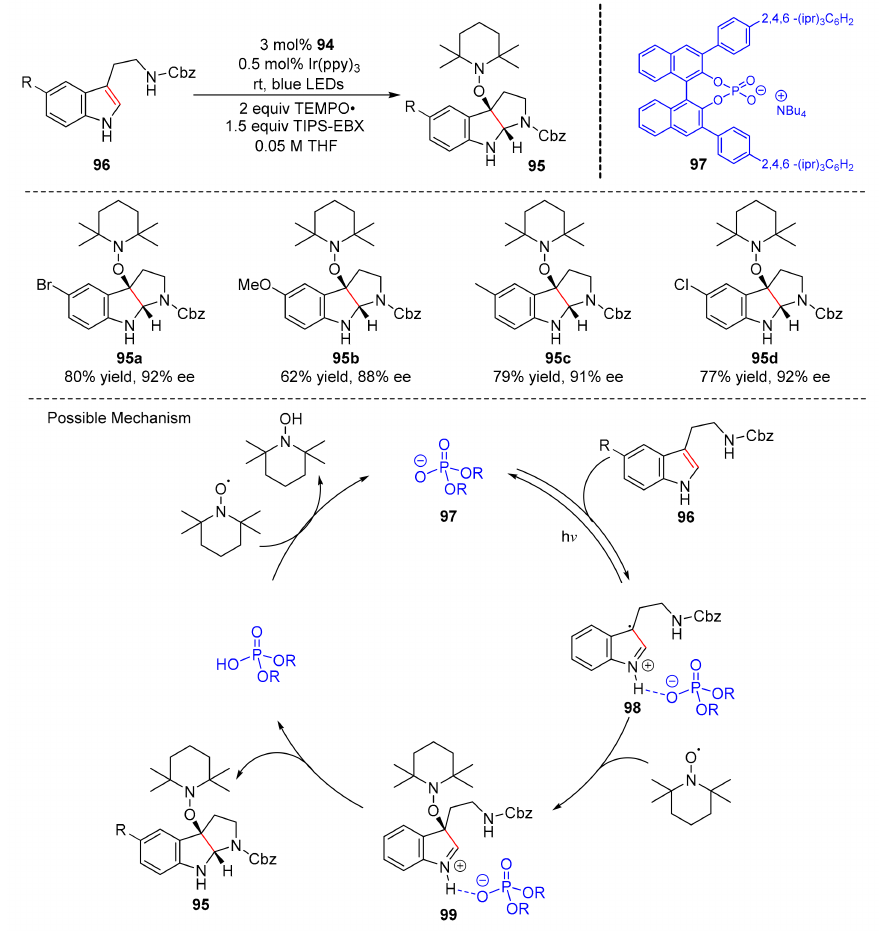
Scheme 22. Enantioselective synthesis of